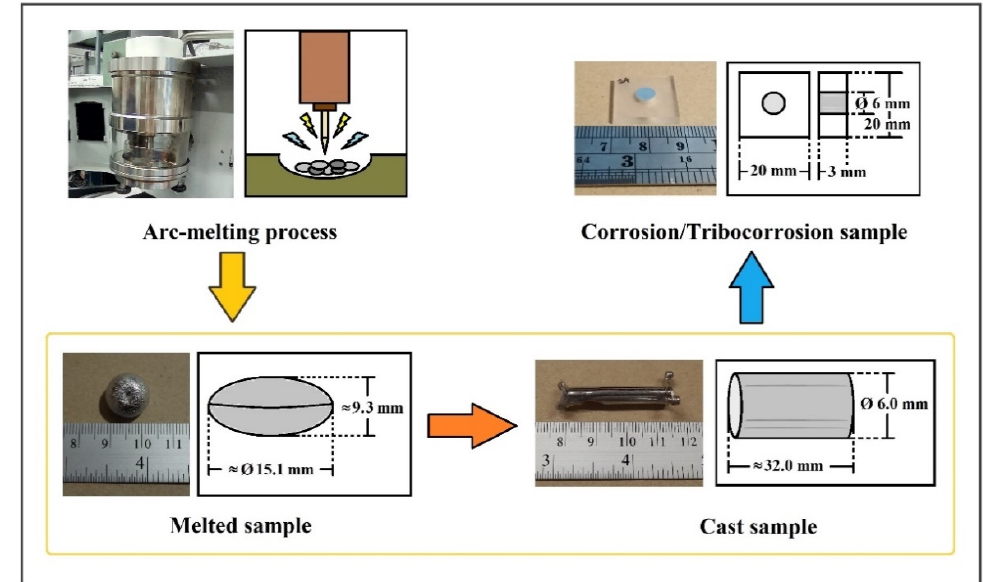
Figure 1. High entropy alloys (HEA) sample preparation for corrosion and tribocorrosion analysis.